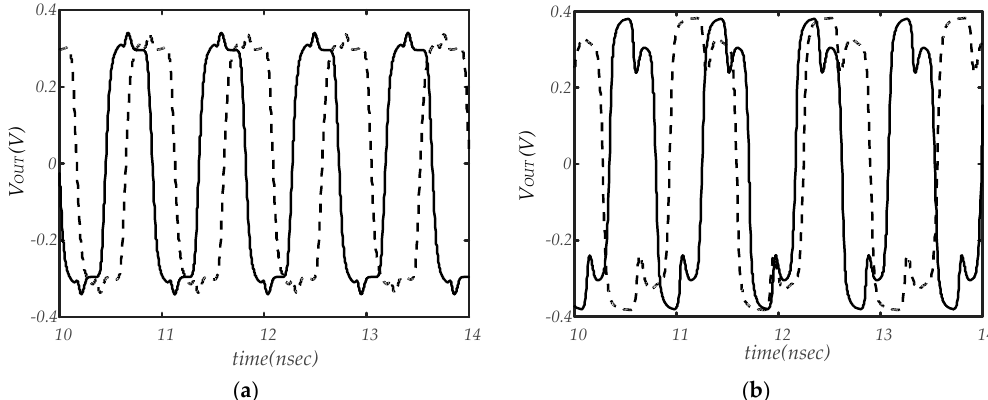
Figure 6. Output waveforms of the divide-by-16 frequency dividers with nType and pType DIV2 blocks without level shifters ( a ) and with only nType DIV2 with input level shifters ( b ). Solid lines refer to maximum speed design whereas dashed lines to minimum PDP design.